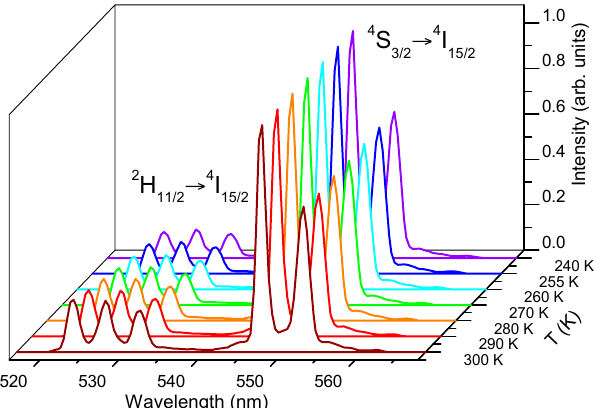
Figure 8. Upconverted green emission as a function of temperature in the 300 K–240 K temperature range obtained under excitation at 806 nm.